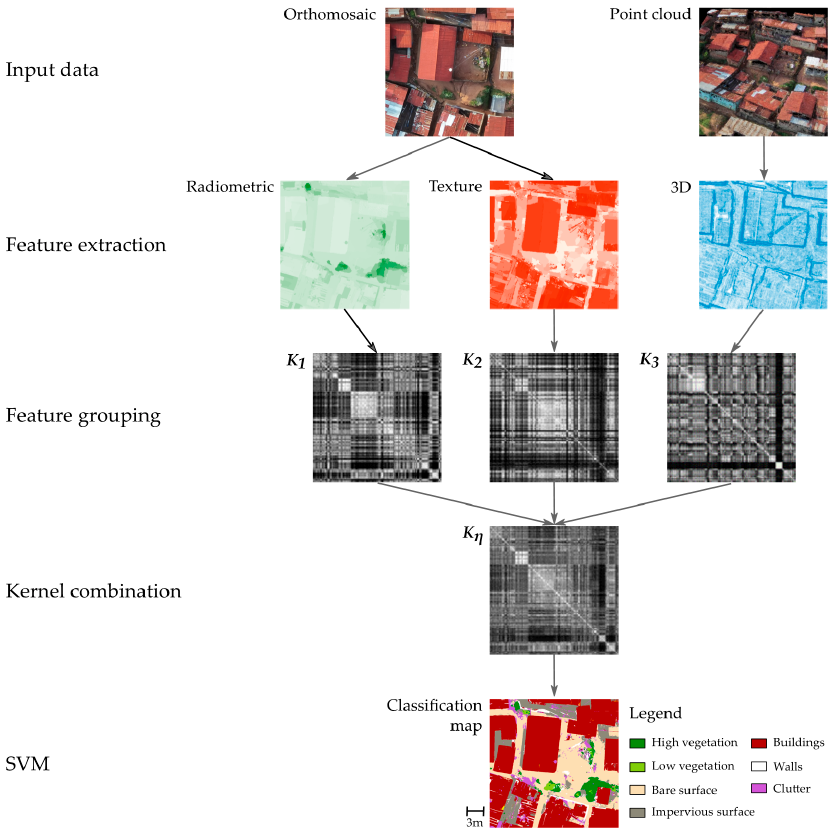
Figure 1. An illustrative example of the multiple kernel learning workflow for UAVs: first,